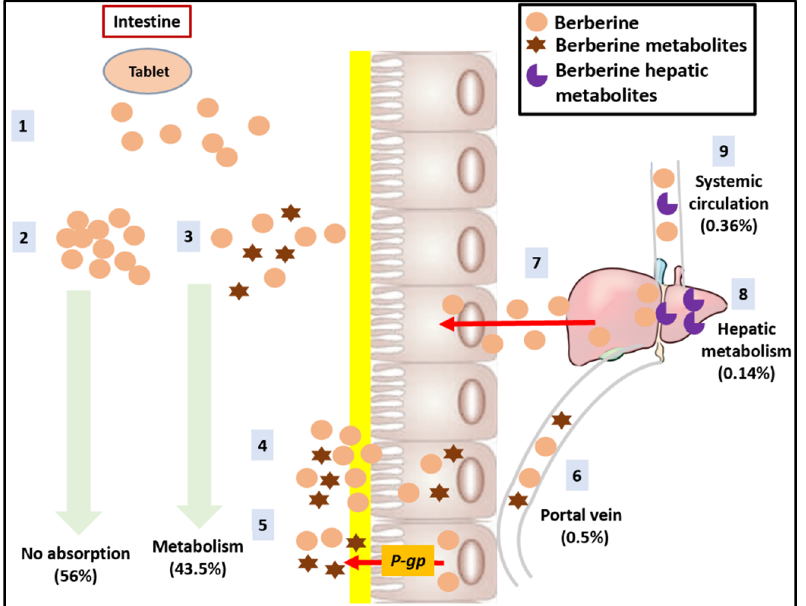
Figure 4. Berberine route after oral supplementation. After ingestion, the tablet disintegrates and releases the BBR particles (1). However, about 56% of BBR is not absorbed in the GI tract due to self-aggregation (2). In addition, intestinal metabolism (operated by both gut microbiota and CYP450) is responsible for the 43.5% of total BBR-particles (3). Finally, the poor permeability (4), P-gp-mediated efflux (5) and hepatobiliary re-excretion (7) also contribute to the reduction of bioavailability. Only 0.5% of BBR enter the portal circulation (6) and 0.36% arrive in the systemic circulation (9).